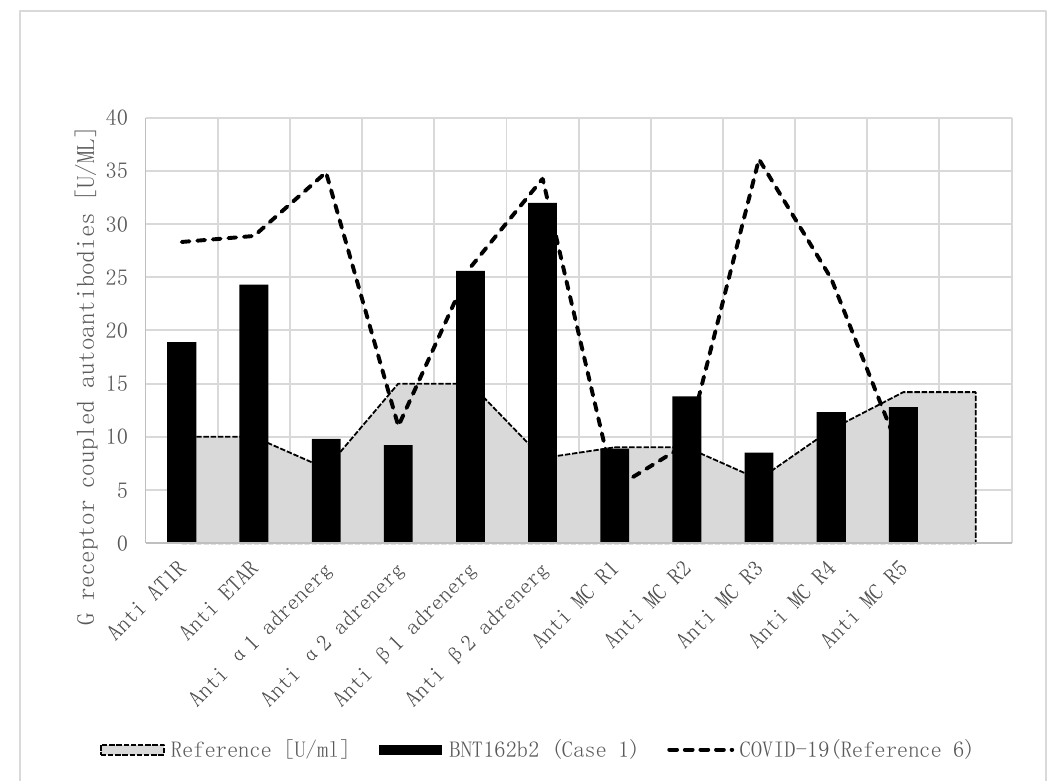
Figure 1. Functional autoantibodies against G-protein-coupled receptors in children with MIS-C after COVID-19 and BNT162b2. Functional autoantibodies against G-protein-coupled receptors in a boy with MIS-C after BNT162b2 vaccination (Case1), and the mean of four published children with MIS-C after COVID-19. Compared to healthy controls, anti-angiotensin 1 receptor, anti-endothelin, and anti-β adrenergic receptor autoantibodies were elevated. Additionally, elevated anti-α1 adrenergic receptor and anti-muscarinic cholinergic receptor-3/4 autoantibodies were only measured in the four children with MIS-C after COVID-19. Anti-AT1R : anti-angiotensin 1 receptor autoantibody; anti-ETAR : anti-endothelin receptor autoantibody; anti-α1 adrenerg : anti-α1 adrenergic receptor autoantibody; anti-α2 adrenerg : anti-α2 adrenergic receptor autoantibody; anti-β1 adrenerg : anti-β1 adrenergic receptor autoantibody; anti-β2 adrenerg : anti-β2 adrenergic receptor autoantibody; anti-MC R1 : anti-muscarinic cholinergic receptor-1 autoantibody; anti-MC R2 : anti-muscarinic cholinergic receptor-2 autoantibody; anti-MC R3 : anti-muscarinic cholinergic receptor-3 autoantibody; anti-MC R4 : anti-muscarinic cholinergic receptor-4 autoantibody; anti-MC R5 : anti-muscarinic cholinergic receptor-5 autoantibody.